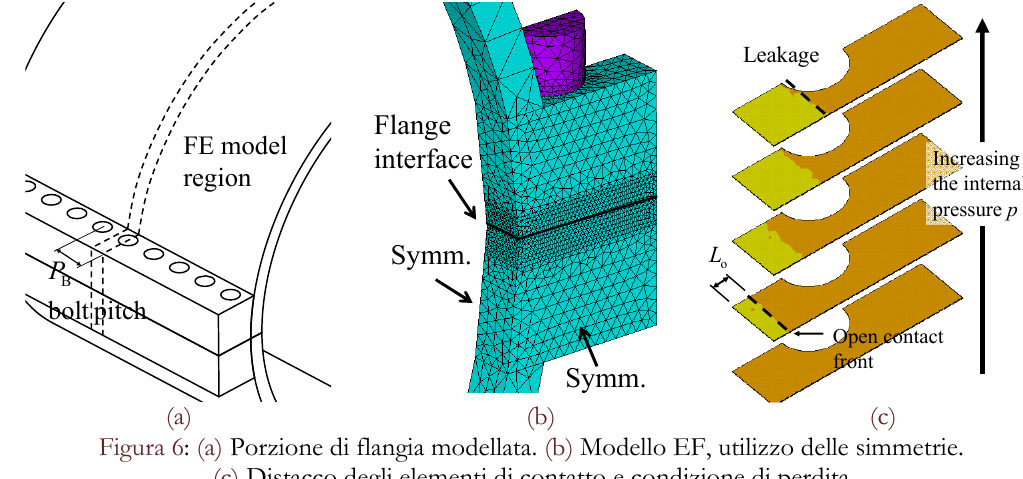
Figura 6: (a) Porzione di flangia modellata. (b) Modello EF, utilizzo delle simmetrie. (c) Distacco degli elementi di contatto e condizione di